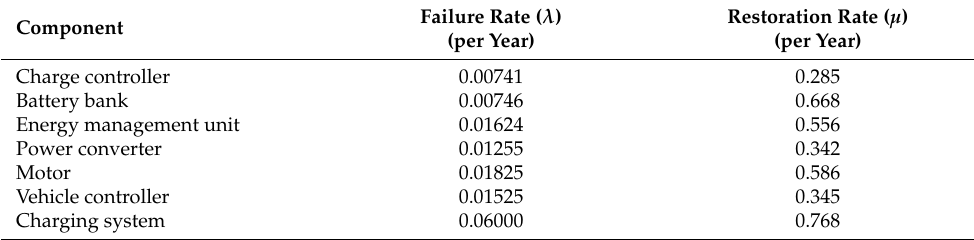
Table A1. Reliability Data for PEV.